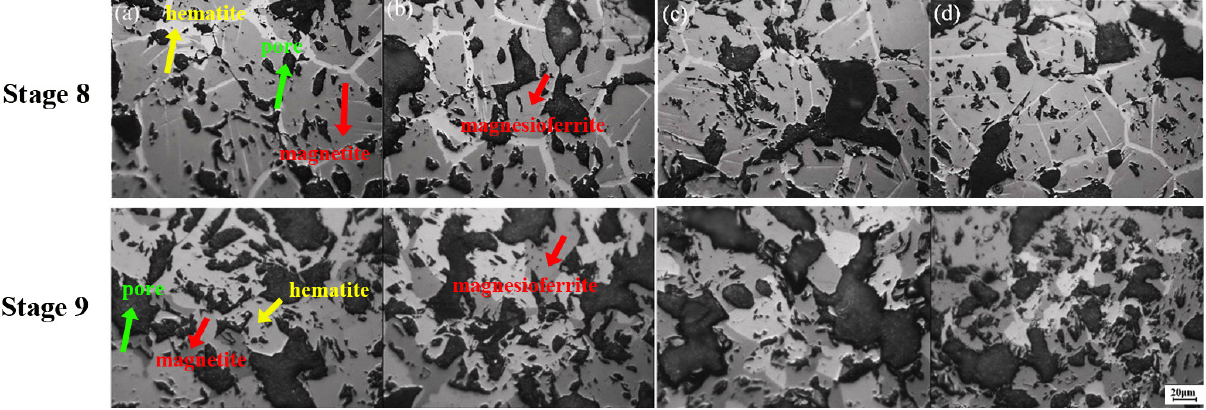
Figure 5. Effect of MgO addition on hematite in the temperature increasing and decreasing process (Stage 6 to Stage 9): ( a ) quantitative variations in oxygen and ferrous; ( b ) XRD patterns of Stage 7; ( c ) XRD patterns of Stage 8; ( d ) XRD patterns of Stage 9.